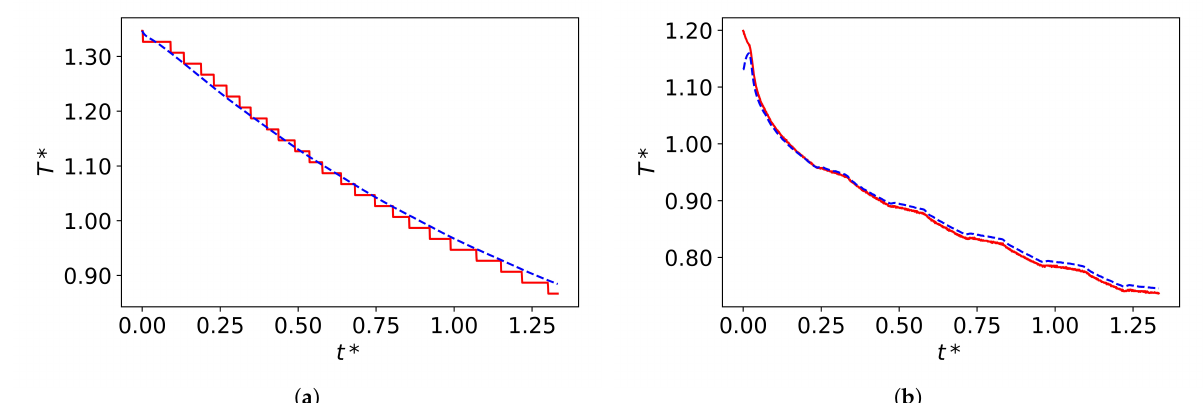
Figure 10. Results for Case 4: ( a ) average battery pack temperature and ( b ) outlet coolant temperature. Measured quantity ; simulated quantity